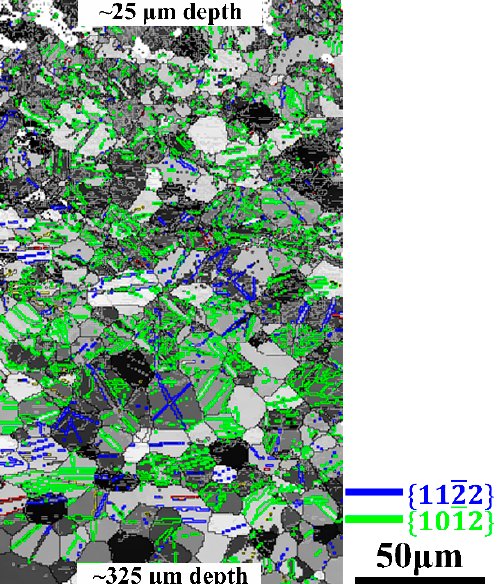
Figure 2. An electron backscattering diffraction (EBSD) image at the depth of 25 μ m to 325 μ m from rotationally accelerated shot peening (RASP)-processed Ti; boundaries are colored black, white, blue and green corresponding to high-angle grain boundaries (HABs), low-angle grain boundaries (LABs), { 1122 } compression twins (CTs) and { 1012 } extrusion twins (ETs),